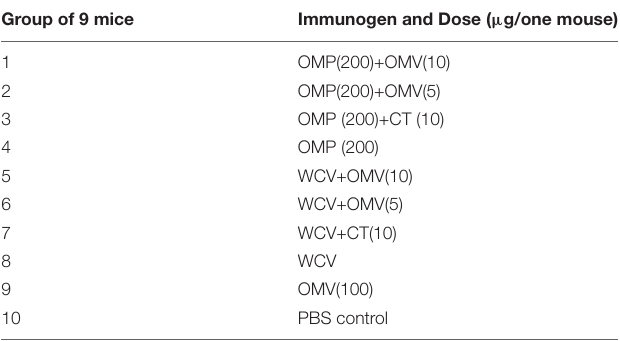
TABLE 1 | Vaccine formulation strategy for immunization using H. pylori OMVs*. Group of 9